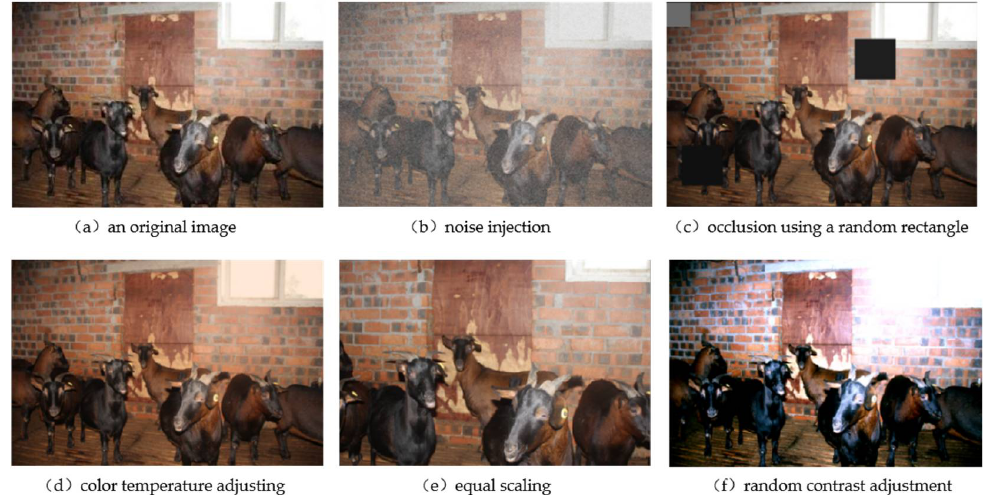
Figure 1. Images of single sample augmentation.